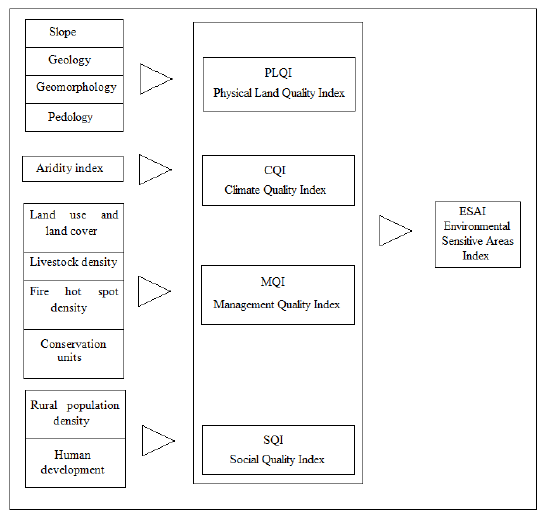
Figure 2. Combination of indicators for the determination of the ESAI; adapted from Benabderrahmane and Chenchouni